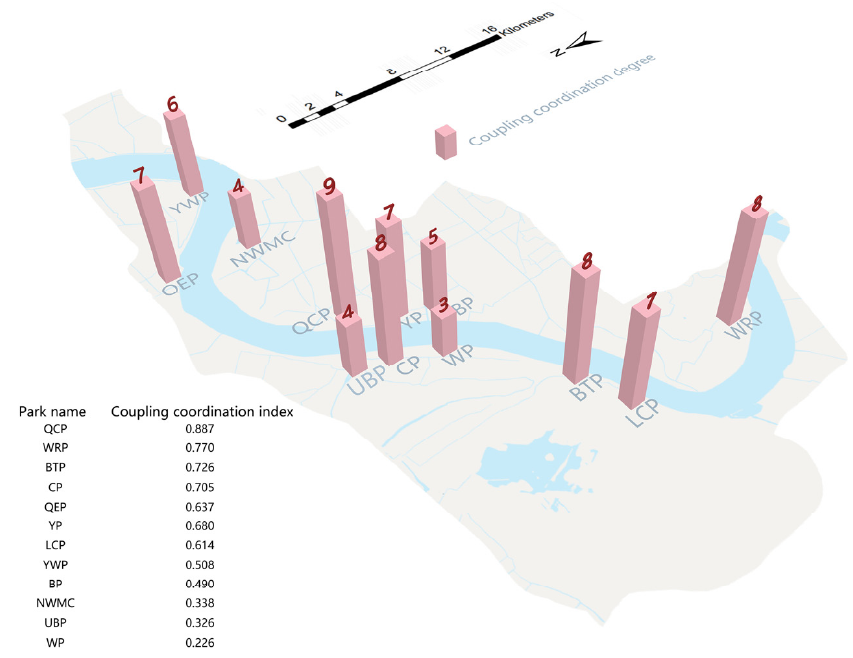
Figure 7. Coupling coordination degree distribution of waterfront parks.